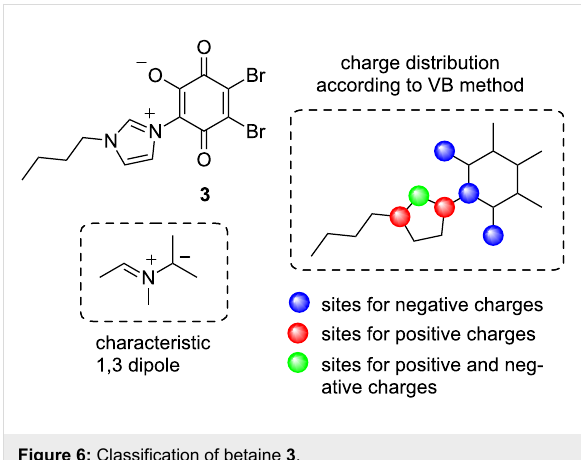
Figure 6: Classification of betaine 3